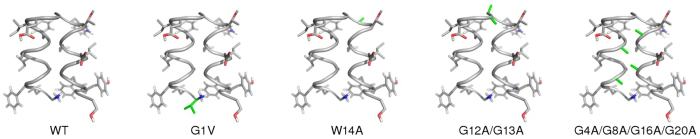
Location of the mutations on the structure of the influenza fusion peptide.The structure of the WT peptide in detergent micelles [13] is displayed in the left panel. The other panels show the location of the mutations analysed in this work, which are highlighted in green. The peptide backbone is shown with a grey cartoon representation and the residue side chains are displayed as sticks with carbon, oxygen, nitrogen and hydrogen atoms coloured in grey, red, blue and white, respectively.